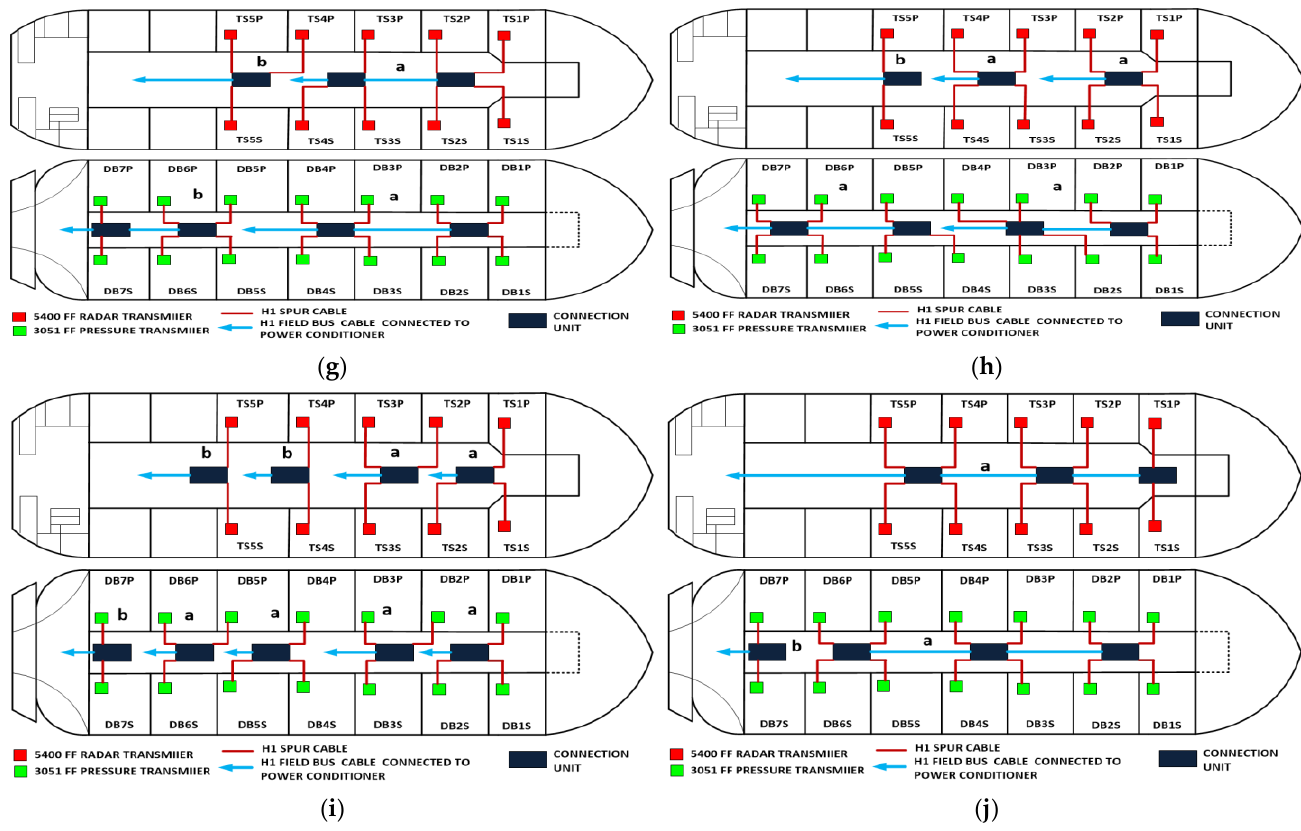
Figure 7. Layout of field device connection blocks for FF models. Connections units used differ according to the model (megablocks, megablocks with SC protection, field barriers or segment protectors). DB and TS refer to double bottom and top side tanks, respectively. S and P refer to starboard and port sides of the ship, respectively. Letters a and b on each layout refer to segments included in each sub-model as indicated in Table 1. ( a ) Non-intrinsically safe and HPTC model. ( b ) Intrinsically safe entity model. ( c ) Intrinsically safe FISCO IIB model. ( d ) Intrinsically safe FISCO IIC model. ( e ) Intrinsically safe FISCO IIB SC model. ( f ) Intrinsically safe FNICO IIB model. ( g ) Intrinsically safe FNICO IIB SC model. ( h ) Intrinsically safe FNICO IIC model. ( i ) Intrinsically safe FNICO IIC SC model. ( j ) Intrinsically safe DART model. Table 1. Connection layout for each of the proposed Foundation Fieldbus models. Type of cables used in all models is FF type A 0.8 mm 2 (18 AWG). S/M (Sub-Model), No.S (No. of segments), No.T/S (No. of Transmitters/Segments), P/S (Power Supply), A/V (Available Voltage), C/U (Con- nection Unit), T.Cur (Total Current Consumption), R.Cur (Rated Current), Max.S/L (Maximum Spur Length). FF Sub-Model